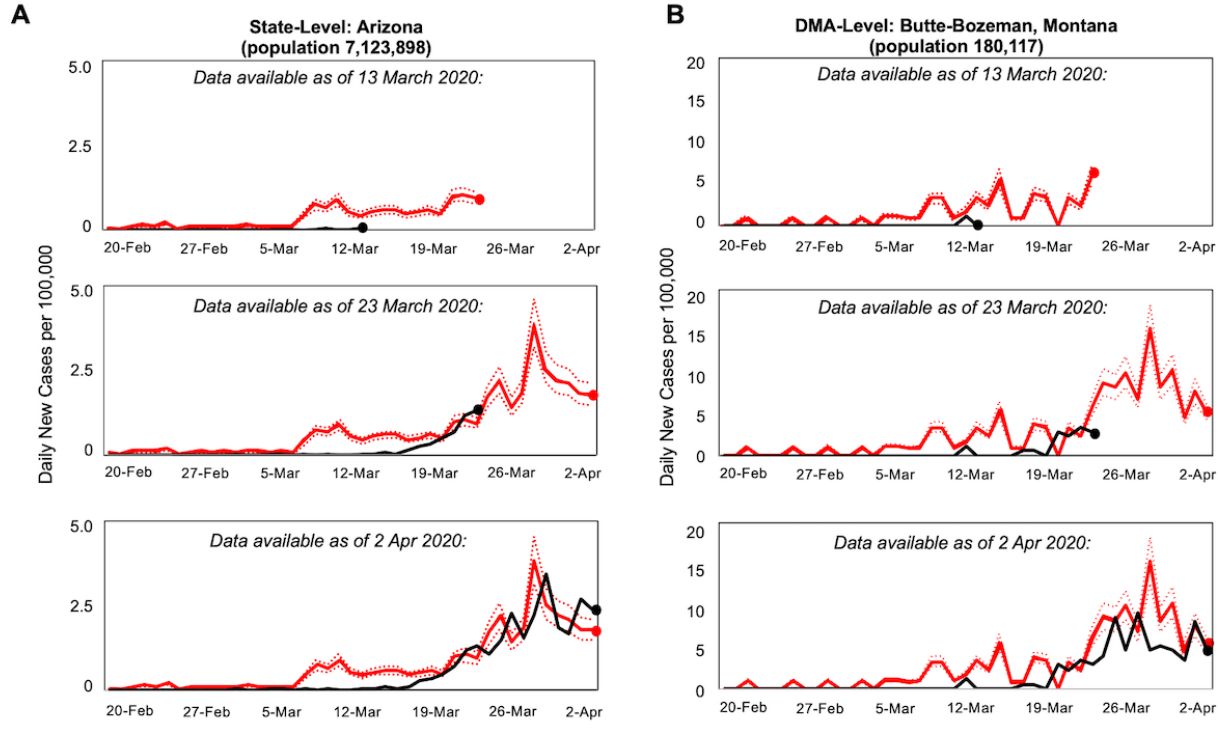
Figure 2. Correlation of query predictions (red) with regional coronavirus disease (COVID-19) case rates (black) at the state and designated market area (DMA) levels, February 20 to April 2, 2020. (A) Comparison of predicted case rates (red) with actual case rates (black) at the state level, with Arizona shown as an example. Dashed lines indicate 95% CIs. (B) Comparison at the DMA level, with the Butte-Bozeman area shown as an example of predictions in a low-population